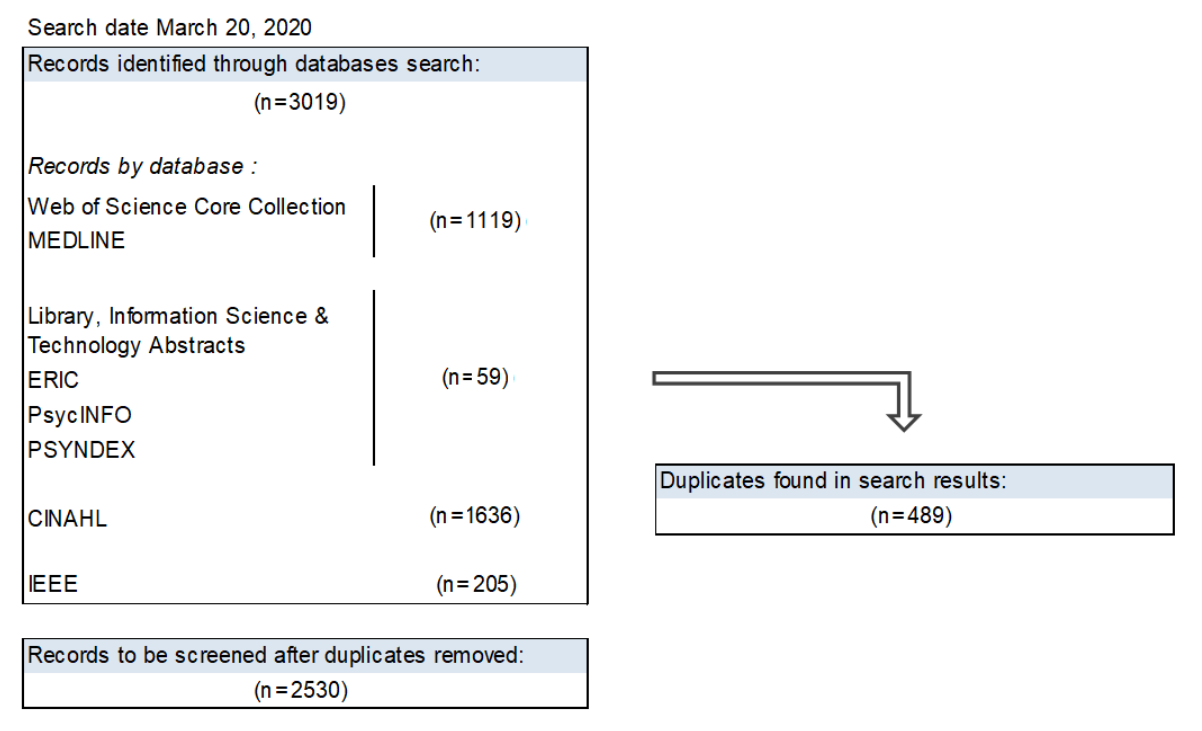
Figure 1. Literature search flow